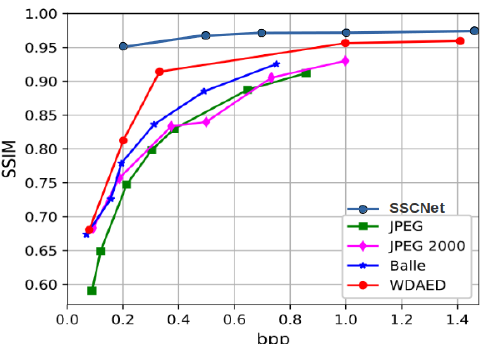
Figure 3. Rate distortion curve on the Kodak dataset using SSIM as evaluation metric over bits per pixel. We used all the results reported in [21,26] as benchmarks and demonstrate to overcome the reconstruction capability of the SSCNet than the others baseline (Balle and WDAED are based on convolutional neural networks) over a 3 channels dataset. We highlight our use of Imagenet- ILSVRC2012 as the training set and Kodak as the test set.